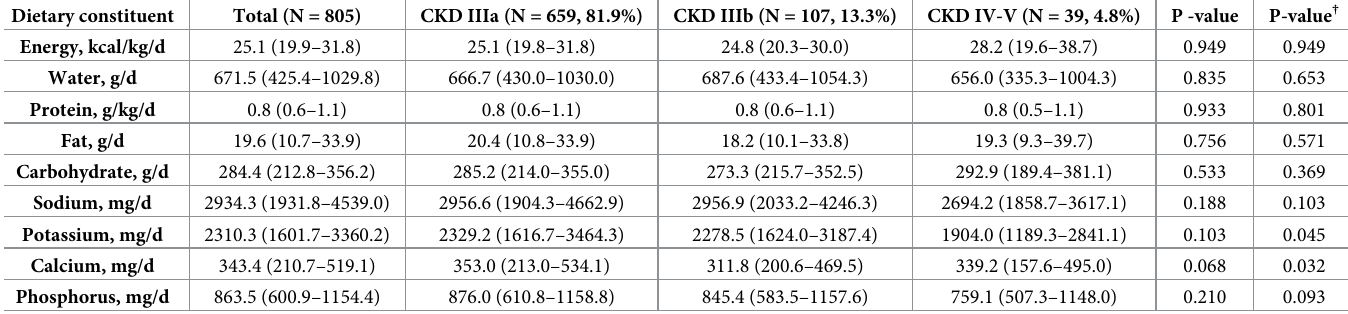
Table 4. Nutritional intake in advanced CKD group �